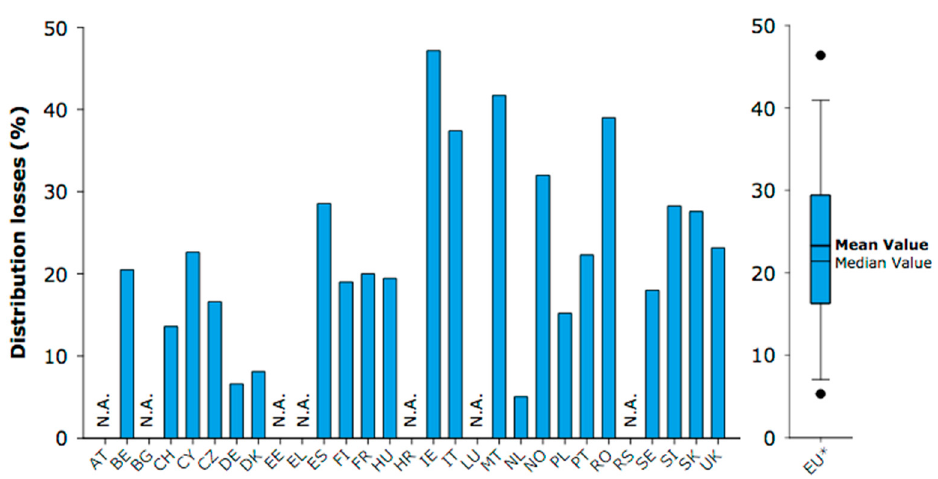
Figure 2. Water distribution losses in EC countries in the 2012–2015 period [4].